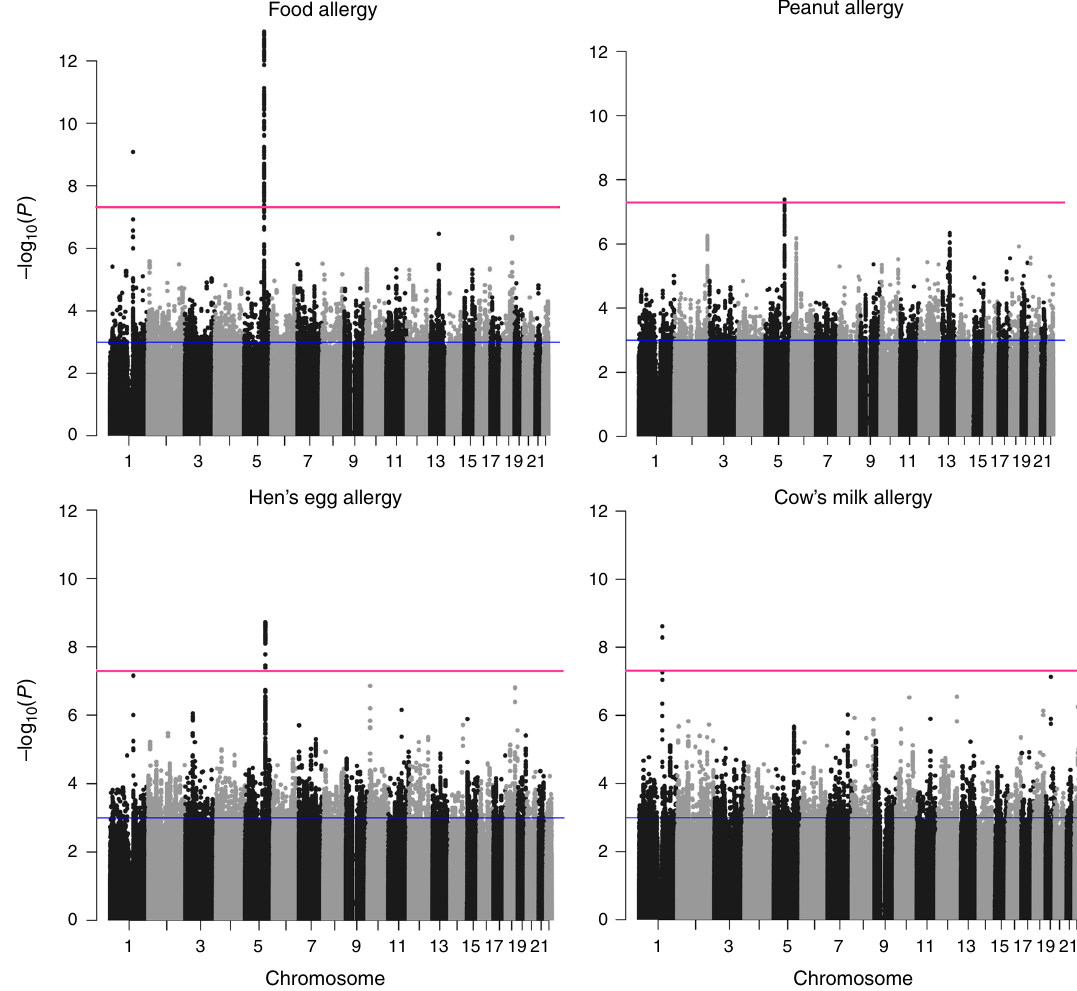
Fig. 2 Association results of the GWAS on food allergy. The results of the GWAS on any food allergy (497 cases vs. 2387 controls) and on food-speci fi c allergies against hen ’ s egg (288 cases), peanut (220 cases), and cow ’ s milk (169 cases) are presented. The Manhattan plots show the chromosomal positions ( x -axis) and association P values ( y -axis) for all SNPs of the discovery set. Red and blue lines indicate the thresholds for genome-wide signi fi cance ( P < 5 × 10 − 8 ) and for entering the replication phase ( P < 1 × 10 − 3 ) respectively